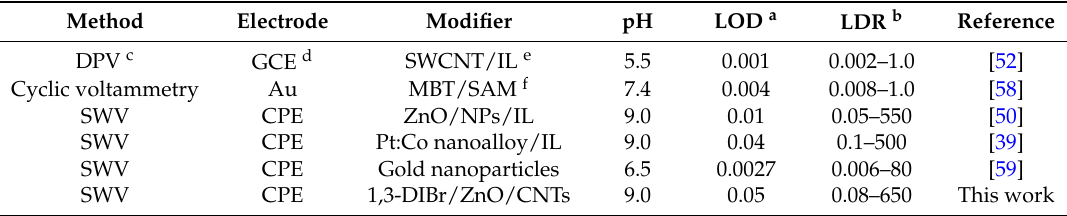
Table 1. Comparison of the efficiency of some electrochemical methods in the determination of vitamin B 9 .